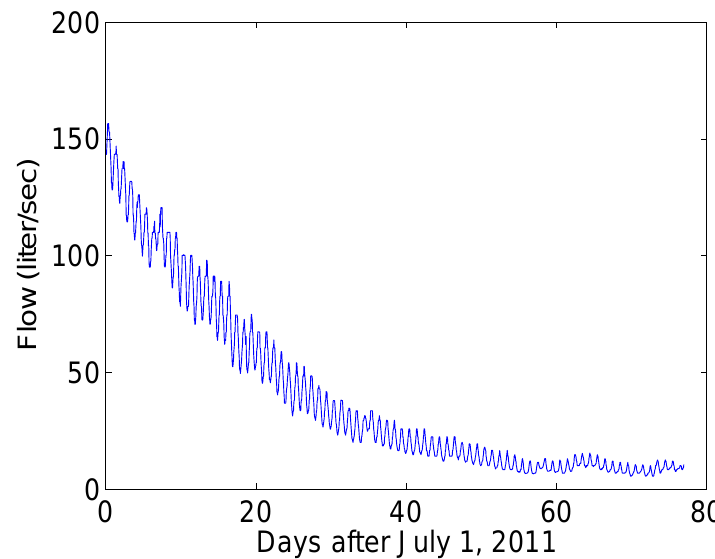
Figure 5. Observed streamflow in Dry Creek Experimental Watershed (Lower Gauge) in